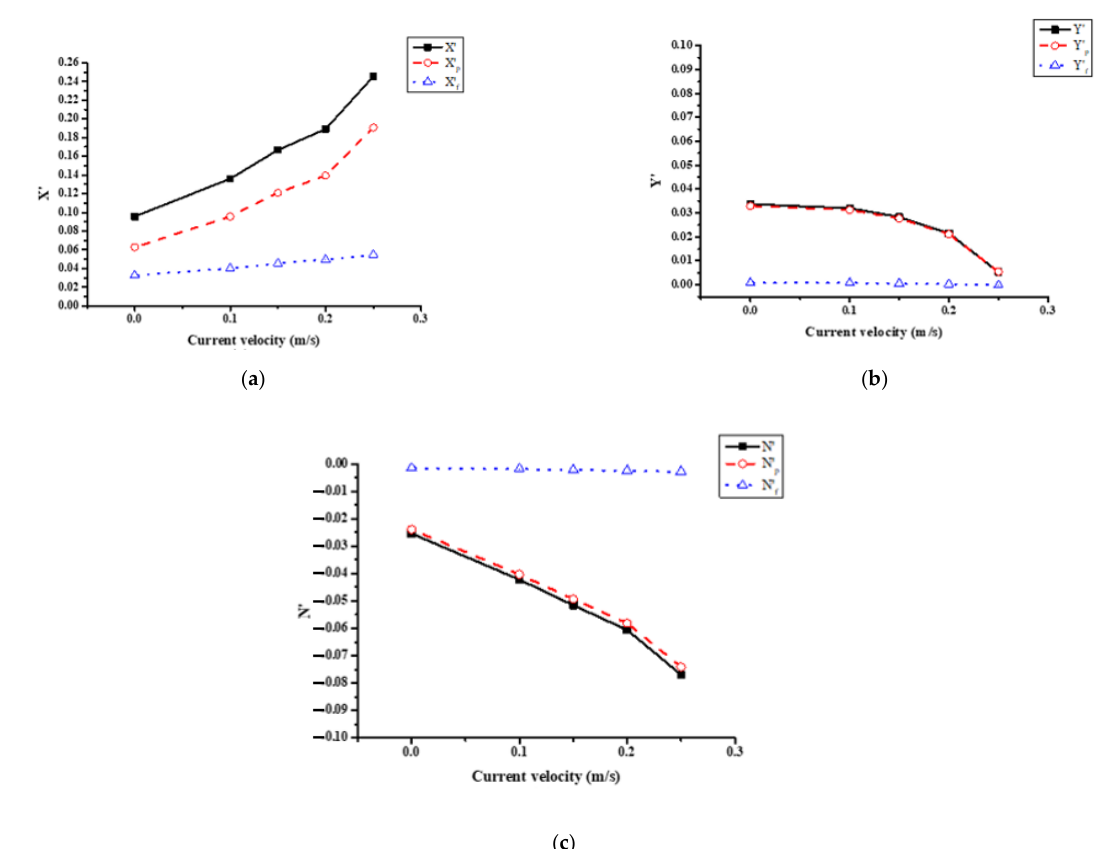
Figure 18. Non–dimensional results of current velocity on ship hydrodynamics ( a – c ): resistance force, sway force, yaw moment.